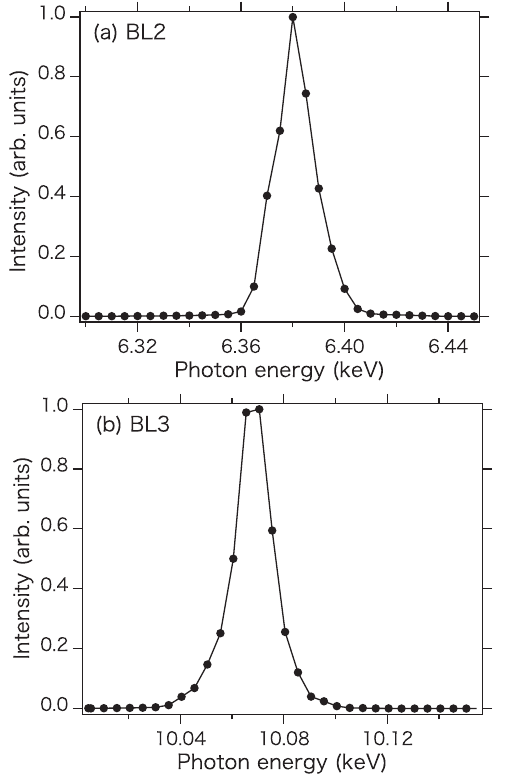
FIG. 8. Averaged laser spectra measured by scanning a mono- chromator in the multi-beam-line operation, (a) BL2 and (b) BL3. The electron beam energy was 7.8 GeV and the undulator K- values were 2.85 and 2.1 for BL2 and BL3, respectively. The peak current is 1.2 kA for both beam lines.